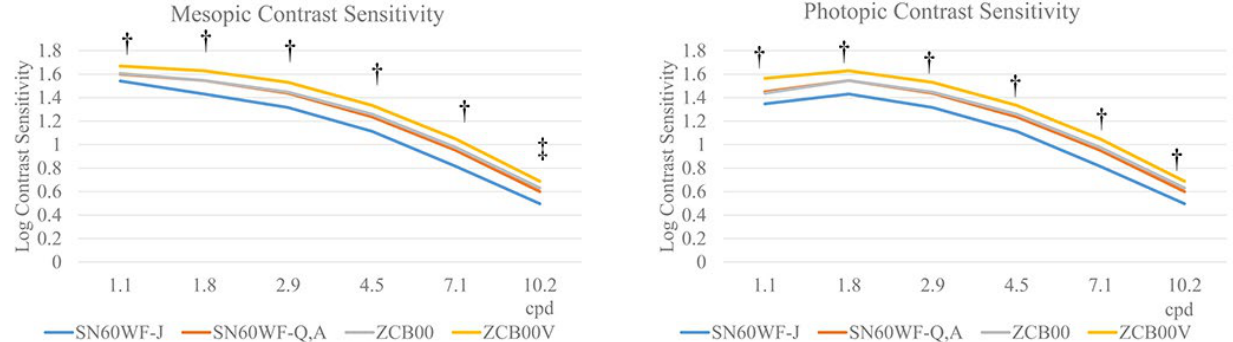
Figure 4. The mesopic contrast sensitivity of the SN60WF-J group was lower than that of the other groups at all cpds. Conversely, the ZCB00V group had significantly better contrast sensitivity. Although significant differences were observed between the SN60WF-Q,A and ZCB00 groups at 10.2 cpd ( p < 0.05), no significant differences were observed at any other cpd. As in the mesopic condition, the contrast sensitivity in the SN60WF-J was lower at all cpd, whereas that in the ZCB00V was better. No significant differences were observed between the SN60WF-Q,A and ZCB00 groups at any cpd. There were † statistical differences between the SN60WF-J group and all other three groups, between the SN60WF-Q,A and ZCB00V groups, and between the ZCB00 and ZCB00V groups. At 10.2 cpd, all groups showed statistically significant differences from all the other groups ( p < 0.05). ‡ All groups showed statistically significant differences from all the other groups ( p < 0.05). Tukey–Kramer test, p < 0.05.